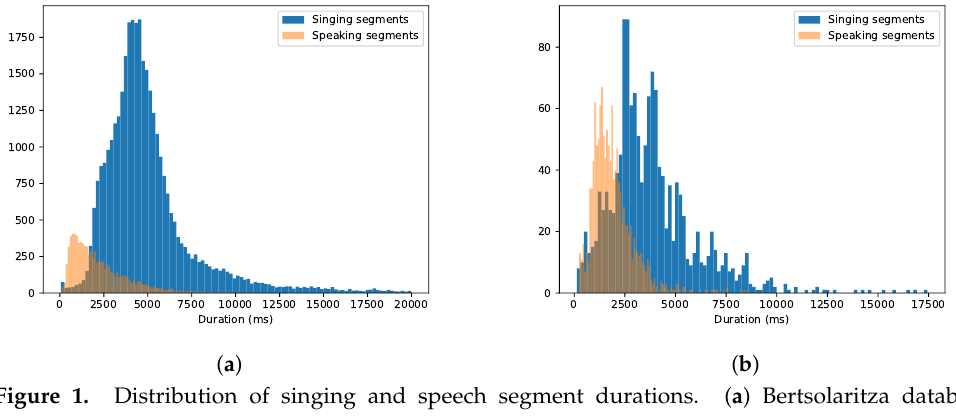
Figure 1. Distribution of singing and speech segment durations. ( a ) Bertsolaritza database; ( b ) NUS